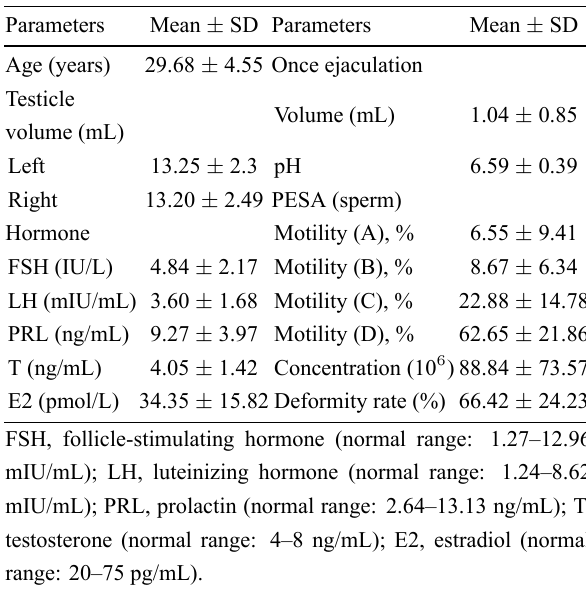
Table 1. General characteristic and laboratory data of the 172 cases with